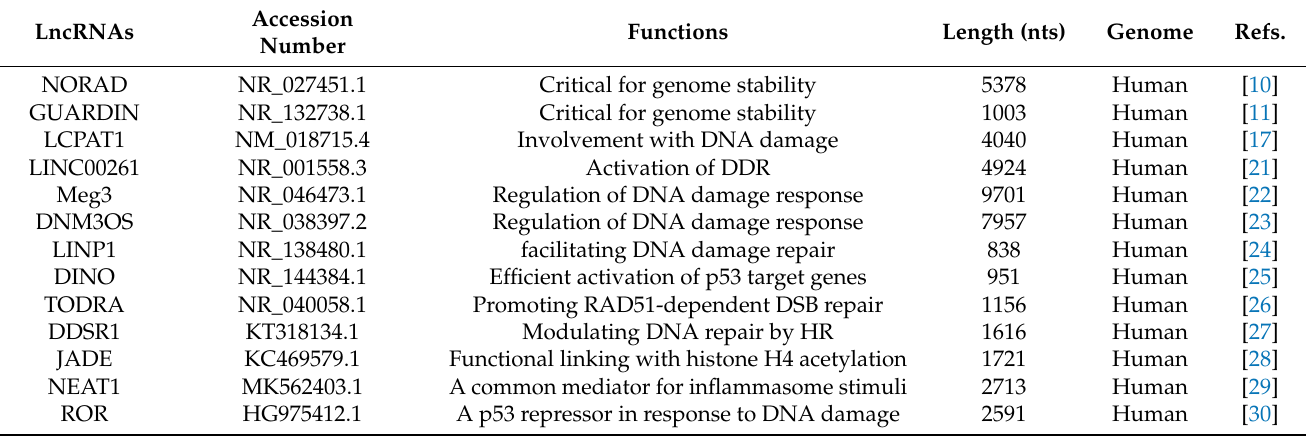
Table 1. Different long noncoding RNA (lncRNA) involvement with DNA